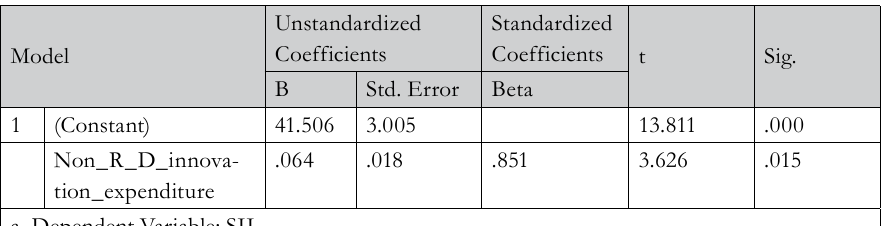
Tab. 11 – Coefficients a – Poland. Source: own processing